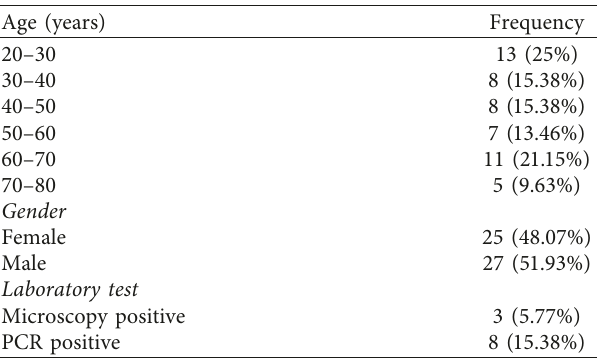
Table 1: Demographic and laboratory analysis ( n �